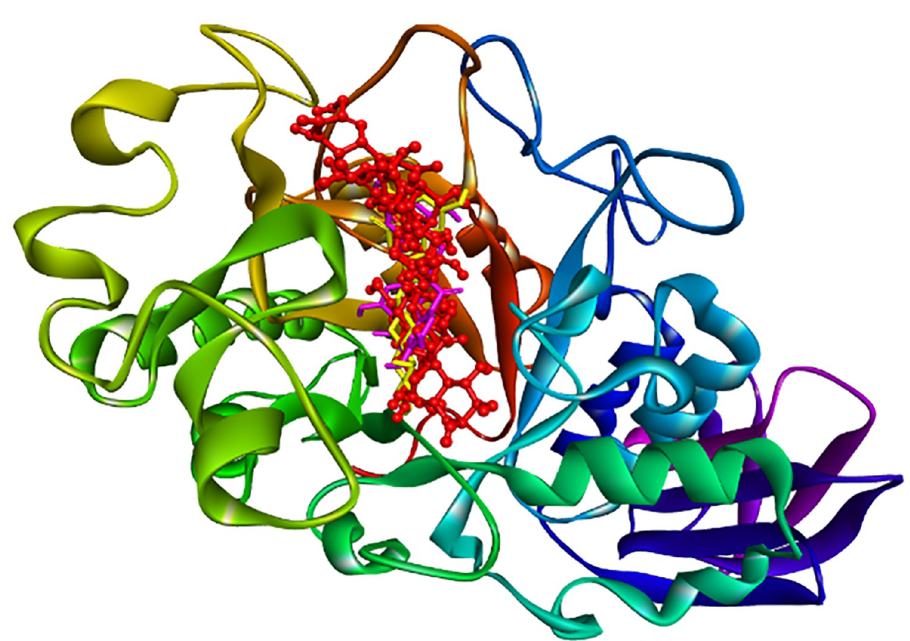
Fig 6. 3D interactions between predicted leading compounds EGCG (pink), plantagoside (yellow), the known inhibitor acarbose (red) and 1OSE.